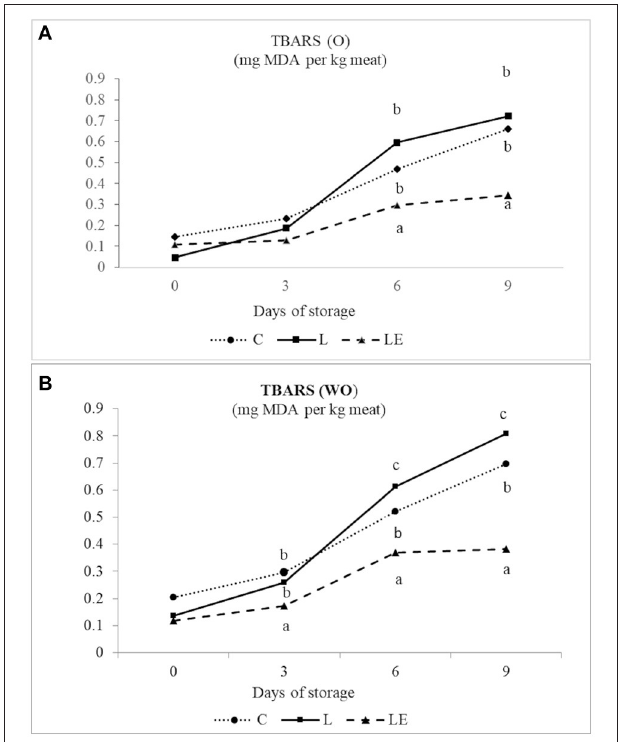
FIGURE 3 | Effect of experimental diets (C, L, and LE) on TBARS concentration in Marchigiana beef meat treated with (O) (A) and without essential oils (WO) (B) during the storage time.